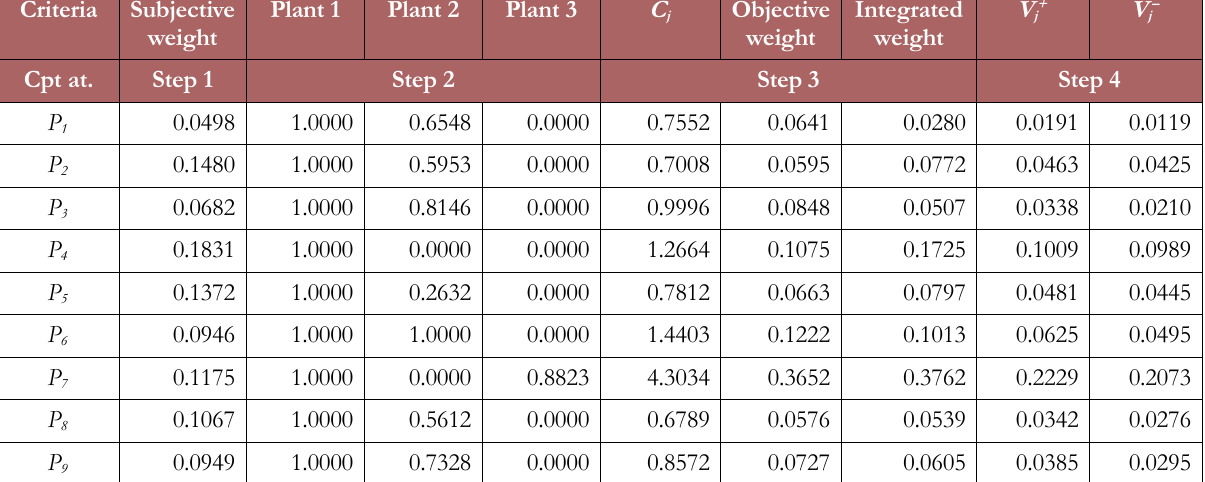
Table 1. Computation of rough BWM-CRITIC-TOPSIS for the nine pillars